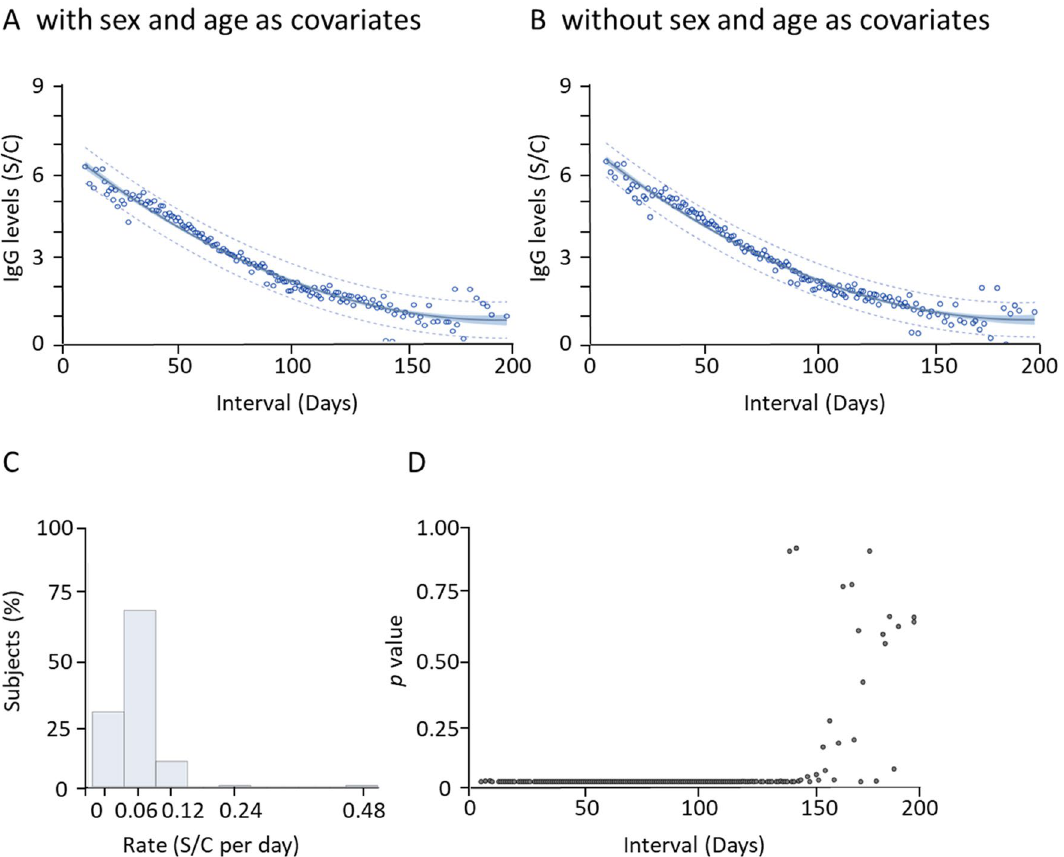
Figure 4. Antibody decay for 4 months after last day showing symptoms. ( A ) Mean anti-N IgG levels were calculated at each time point from the mixed model estimation with sex and age as covariates. Each dot represents the estimated IgG level at that time point. The solid curve line is the estimated fitting model. The blue shaded band shows the 95% confidence interval for the IgG level, and the dashed band shows the 95% prediction interval for the IgG level with this model. ( B ) Mean anti-N IgG levels were calculated at each time point from the mixed model estimation without sex and age as covariates. ( C ) Distribution of overall decline rates from all patients. The rate was defined as the difference between the first- and last-day anti-N IgG levels divided by the time interval. ( D ) The variation of anti-N IgG levels at individual time points from day five to day 200 since the last day showing symptoms was calculated. Due to the multiple simultaneous comparisons, Bonferroni adjustment was used to plot the p values against time intervals, and high variation of IgG levels was observed after 120